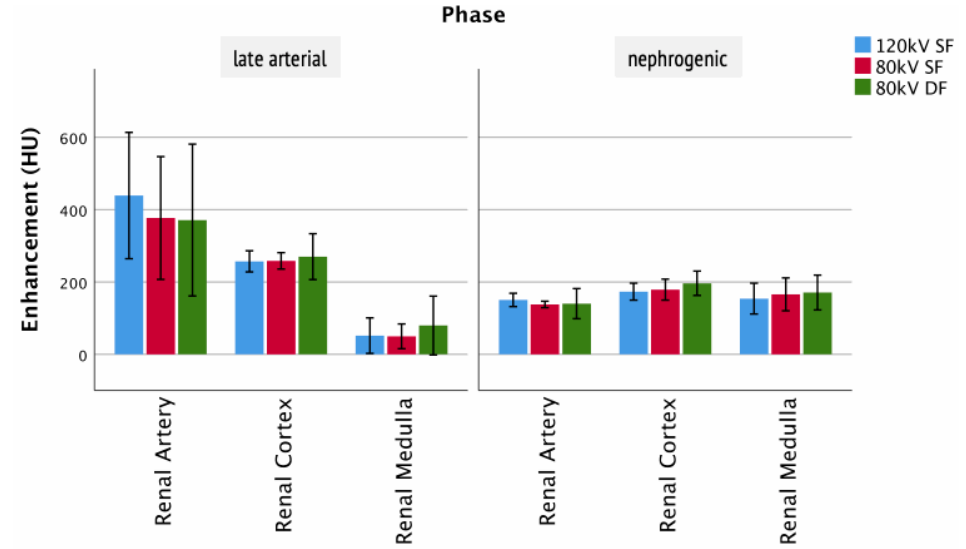
Figure 6. Enhancement of renal structures. Columns show the enhancement of clinically relevant structures of the kidney for the different injection protocols and clinically relevant phases.